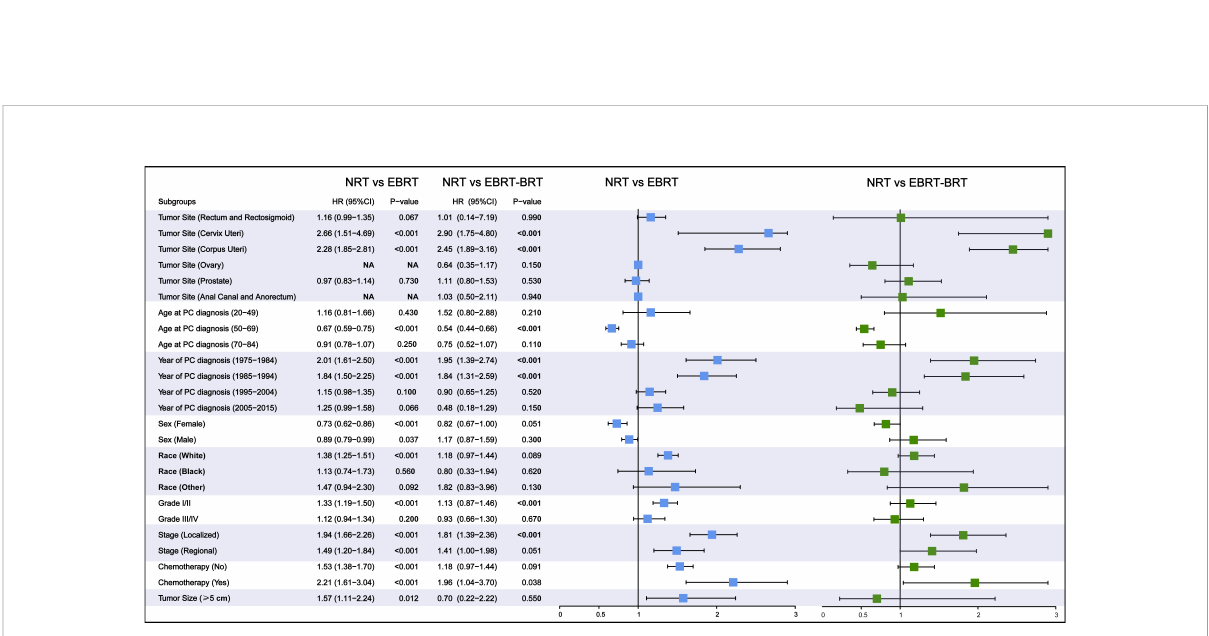
FIGURE 3 Subgroup analyses of competing risk regression for the risk of developing secondary bladder cancer (SBC). PC, pelvic cancers; SBC, secondary bladder cancer; HR, hazard ratio; CI, con fi dence interval; NRT, no radiation therapy; RT, radiation therapy; EBRT, external beam radiation therapy; EBRT – BRT, external beam radiation therapy with brachytherapy involving implants or